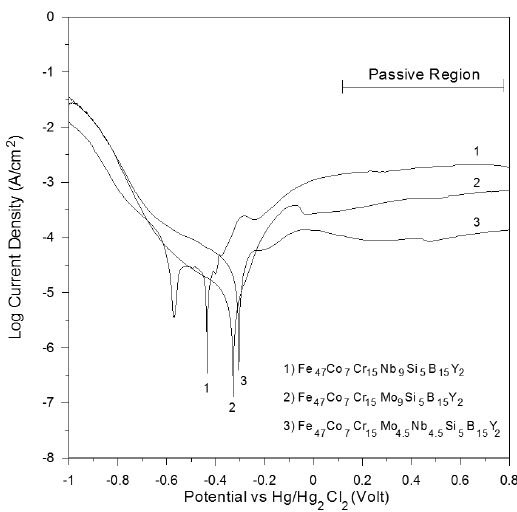
Table 5. Corrosion Potential, E